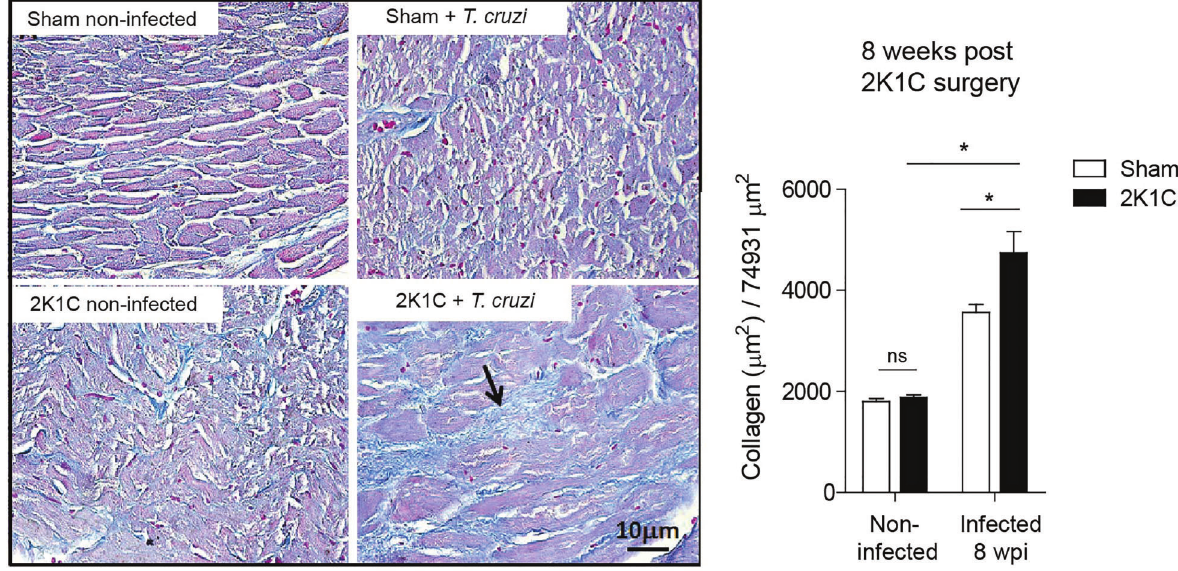
Figure 5. Collagen analysis in two-kidney one-clip (2K1C) infected cardiac tissue. Before and 8 weeks after 2K1C (n=8) and Sham (n=8) surgeries, immediately followed, or not, by infection with the Y strain of T. cruzi , cardiac tissues were stained with Masson ’ s trichrome to quantify collagen using the ImageJ program in a total area of 74,931 m m 2 (magni fi cation 40 (cid:1) ). Data are reported as means ± SE. *P p 0.05 by one-way ANOVA followed by Bonferroni post-test. ns: non-signi fi cant difference. Black arrow: collagen. wpi: weeks post-infection. Magni fi cation bar: 10 m